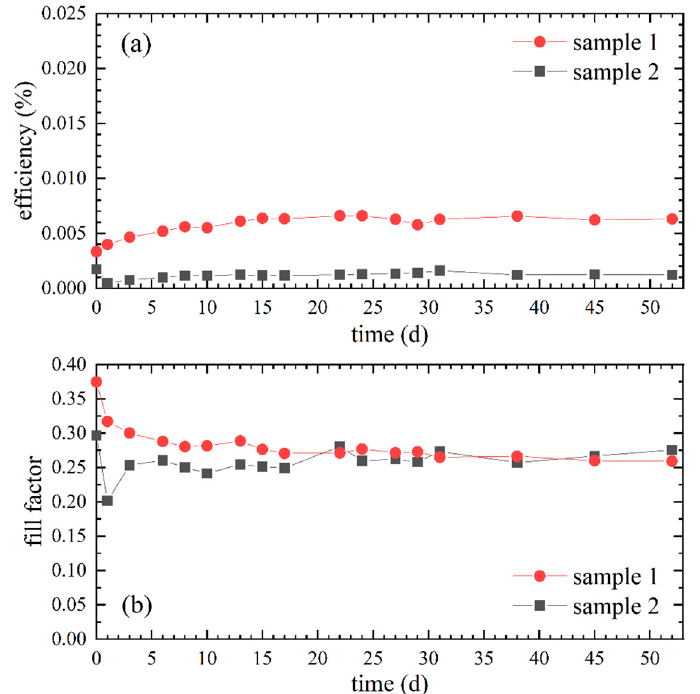
Figure 3. Efficiencies and fill factors of PEO gel electrolyte DSSCs assembled with DMSO and distilled water as solvents measured over 52 days: ( a ) Efficiencies of sample 1 with DMSO as solvent and of sample 2 with distilled water as solvent; ( b ) Corresponding fill factors of sample 1 and 2.